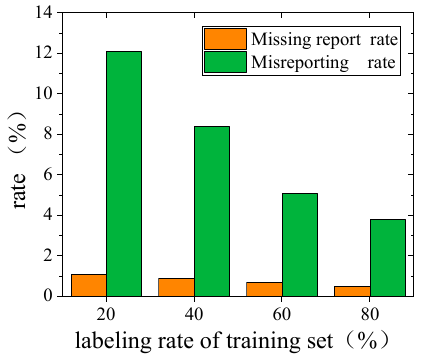
Figure 11. Missing report rate and misreporting rate of falling events.